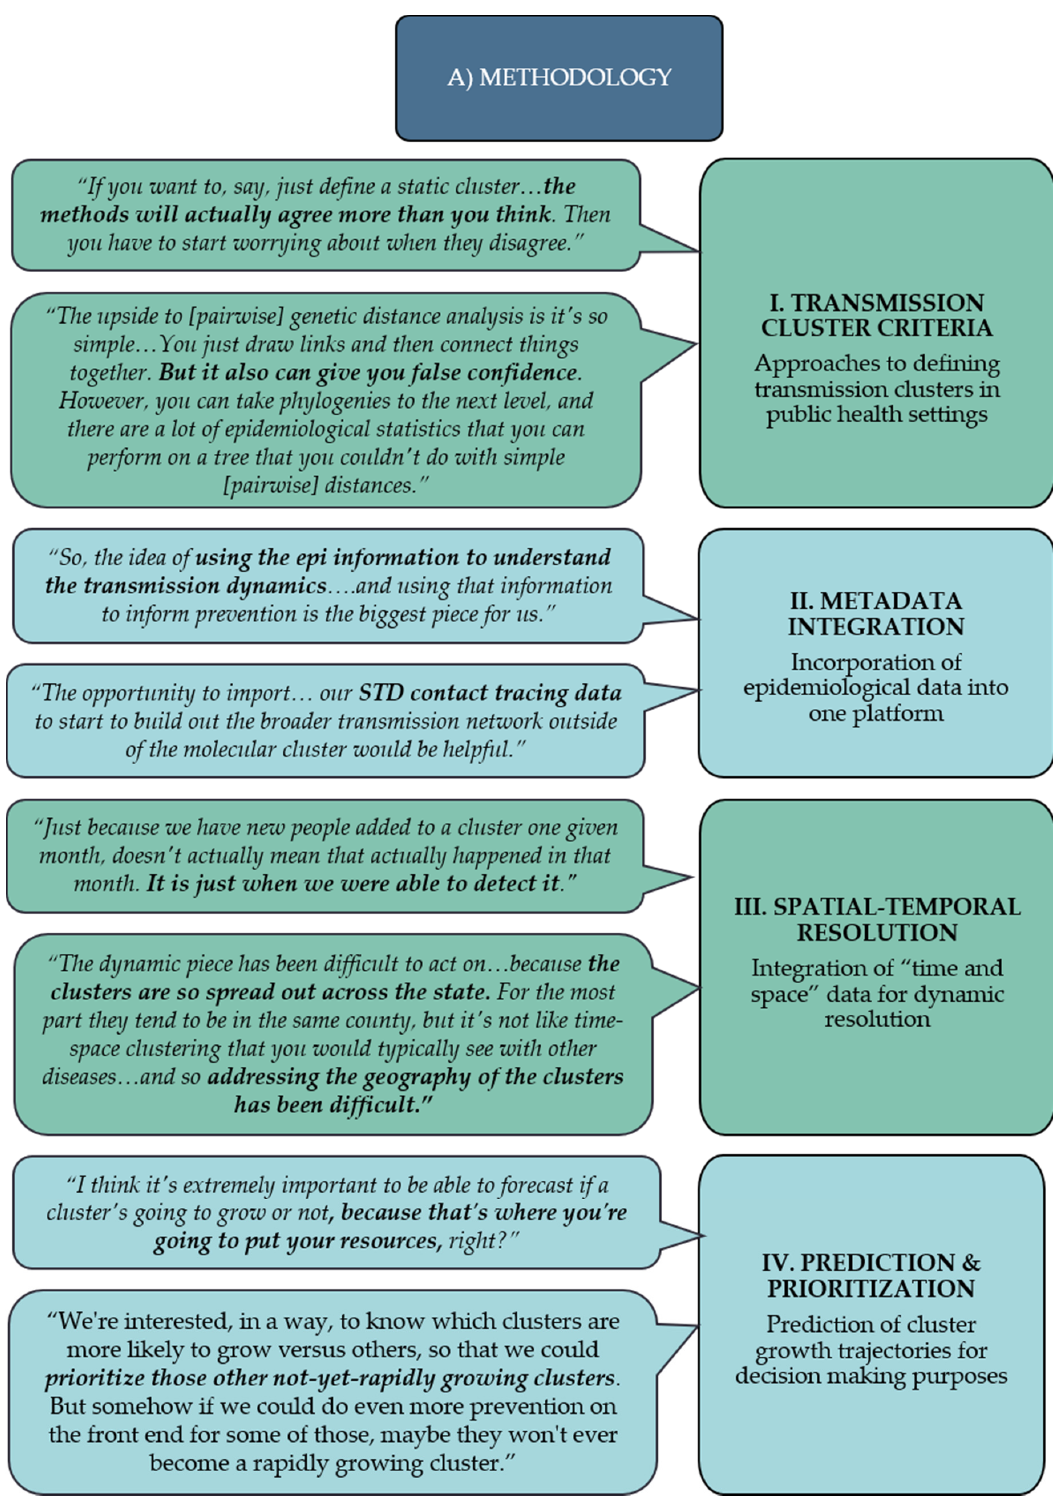
Figure 1. Methodology subthemes and noteworthy quotes from the focus group participants with varying expertise in HIV molecular epidemiology and public health surveillance.